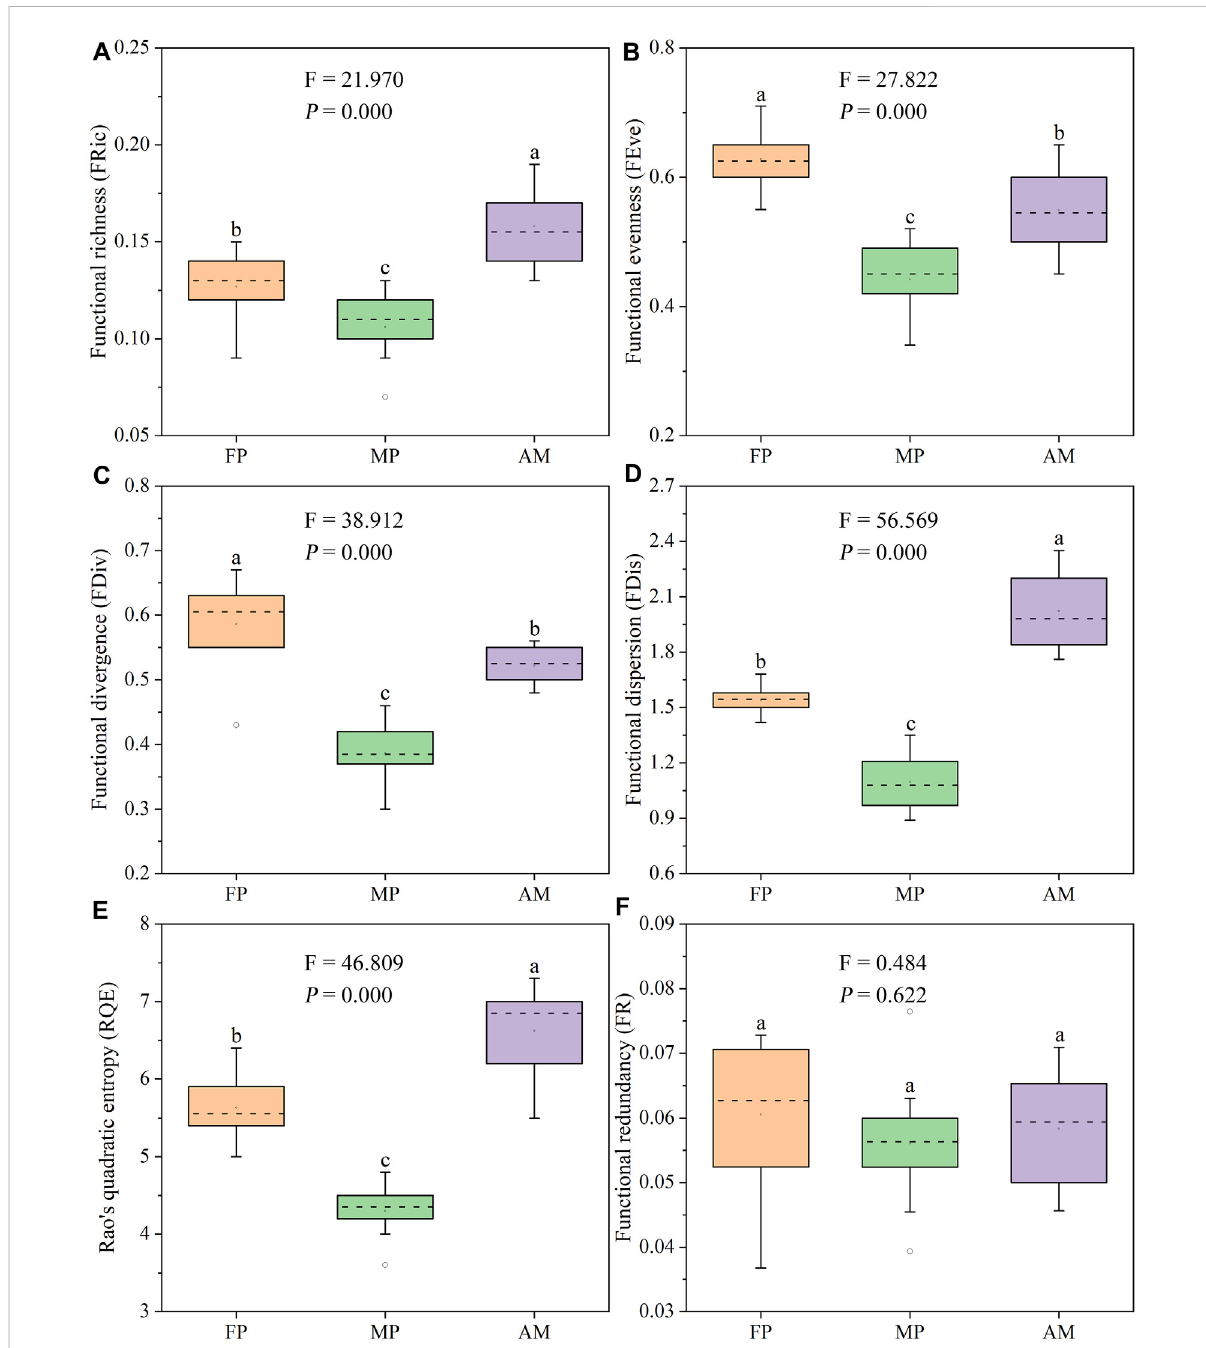
FIGURE 5 Differences in functional richness (A) , functional evenness (B) , functional divergence (C) , functional dispersion (D) , Rao ’ s quadratic entropy (E) , andfunctionalredundancy (F) ofstream macroinvertebrates duringthreeperiodsofsnow melting. FP,freezing period; MP,melting period;AM,after the melting period. Different lowercase letters indicate signi fi cant differences in invertebrate community structure caused by different